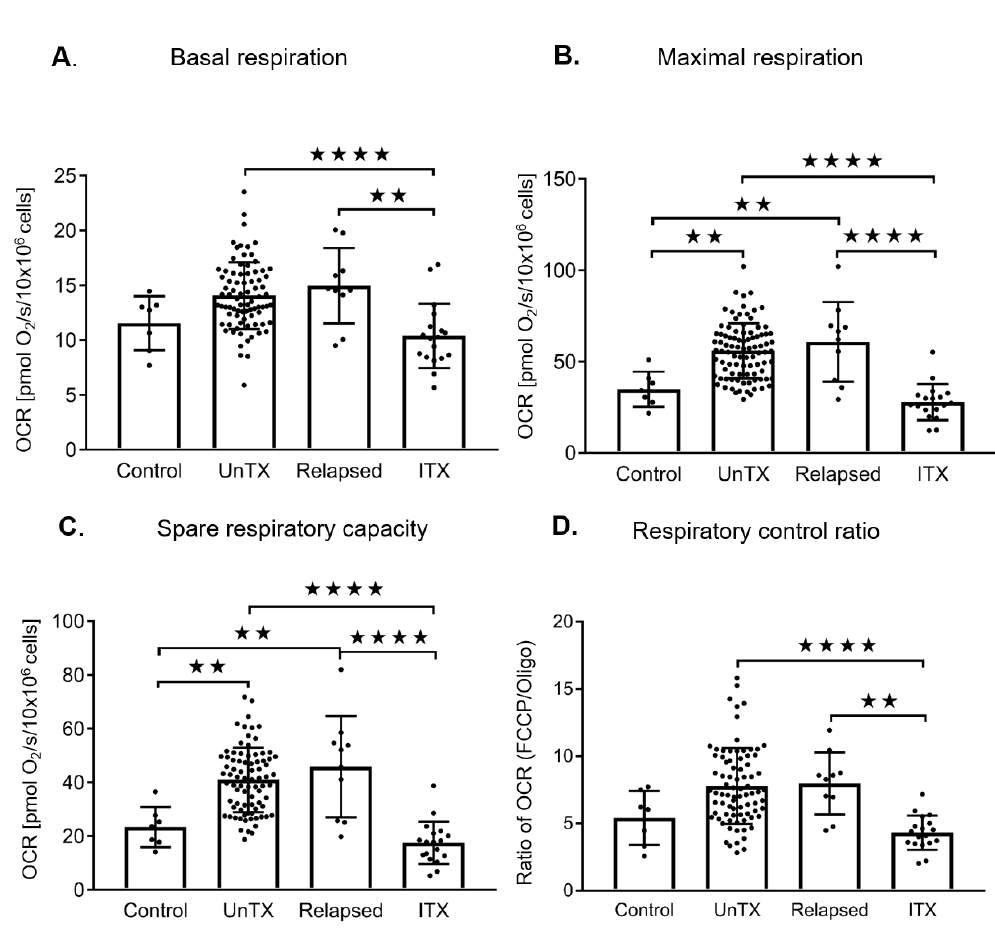
Figure 6. Mitochondrial bioenergetic profiles in freshly isolated B lymphocytes (Control) and CLL cells from untreated, relapsed, and ibrutinib-treated patients. Basal respiration, maximal respiration, the spare respiratory capacity, and the respiratory control ratio are summarized. Untreated, U; relapsed, R; ibrutinib-treated, I; A – D ; N = 7 / 81 / 10 / 18 CLL cells (10 × 10 6 cells), respectively. Values are the mean ± S.D., where ** p < 0.01 and **** p < 0.0001 (one-way ANOVA with Tukey’s post hoc test). Table 3. Comparison of untreated, relapsed, and ibrutinib-treated CLL patients. Comparison of prognostic markers in untreated (U), relapsed (R), and ibrutinib-treated (I) CLL samples. WBC, white blood cell count; ZAP-70, zeta-chain-associated protein of 70 kD; CD38, cluster of differentiation 38; FISH, fluorescence in situ hybridization; IgVH, immunoglobulin variable heavy chain; Um, unmutated; β2-M, β2-microglobulin; PE, parameter estimate; SE, standard error. Bolded values are significant.